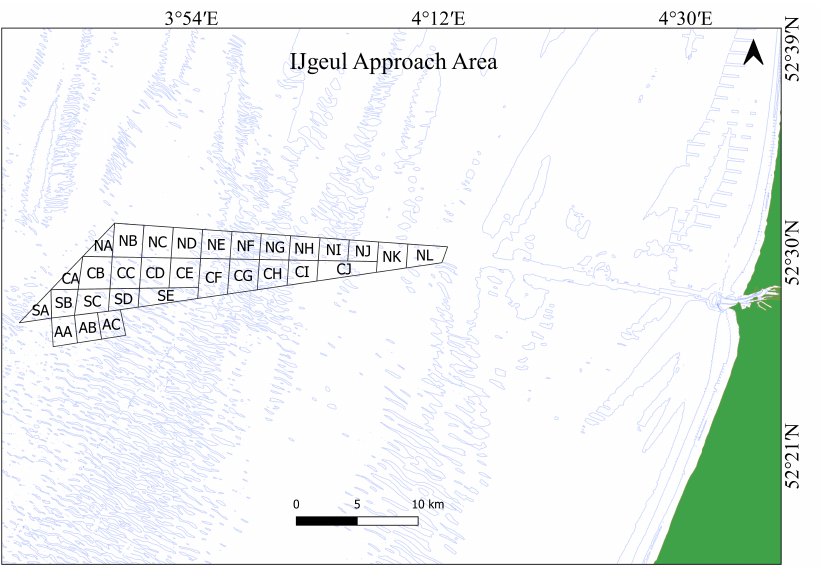
Figure 7. Location of the IJgeul Approach area subdivided into 30 smaller sub-areas and 5 m bathymetry contour. Areas AA, AB and AC are the anchorage